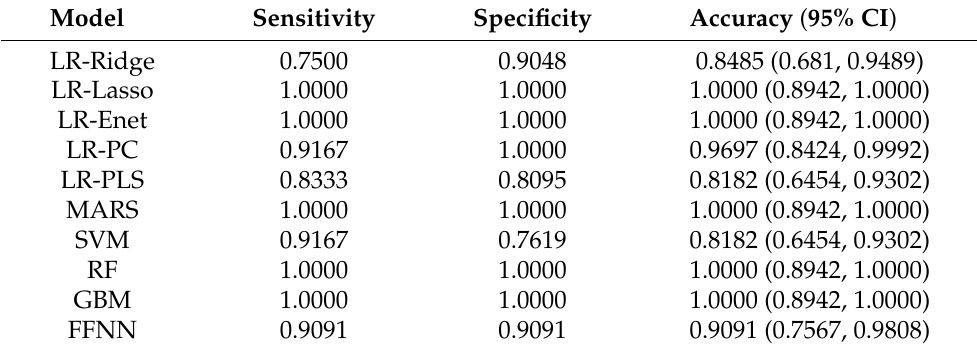
Table 10. Comparing predictive performance of the 10 models applied to the prostate cancer data.